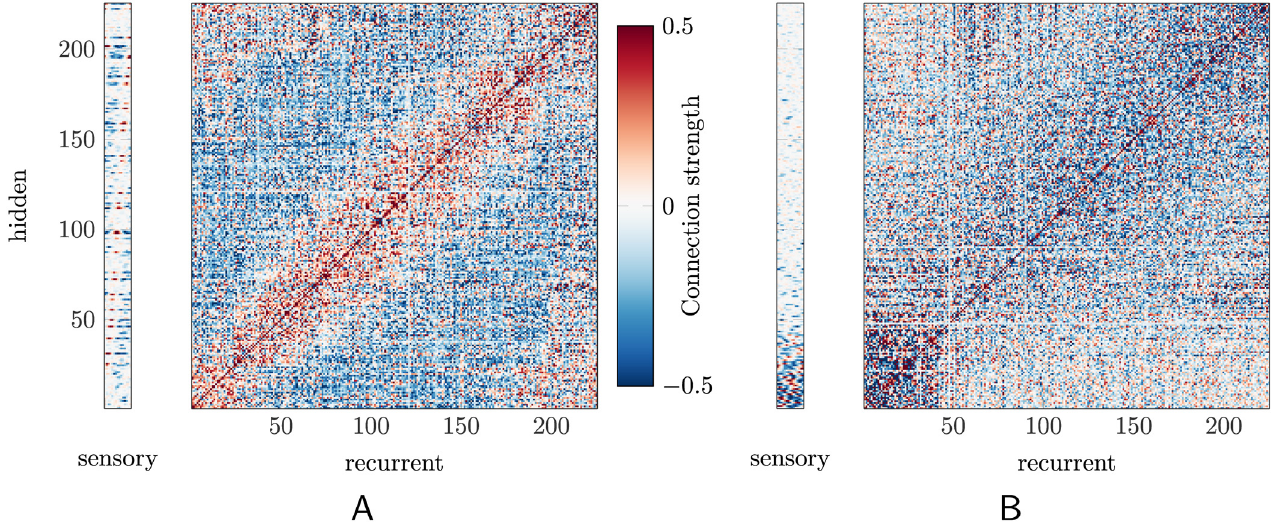
Fig 8. The weight matrices. The organization of connections between inputs (sensory or recurrent units) and the hidden layer can be visualized by sorting units by (A) preferred stimulus angle or (B) by preferred lag (increasing from lower left to upper right). Here we analyze the “ no-spring ” network (see text). In both subfigures, both the recurrent and hidden units have been re-sorted; the sensory units remain organized by preferred angle. Note that self-connections (along the diagonal) are in fact more than 0.5, but the plot saturates at this value to make the other connections more